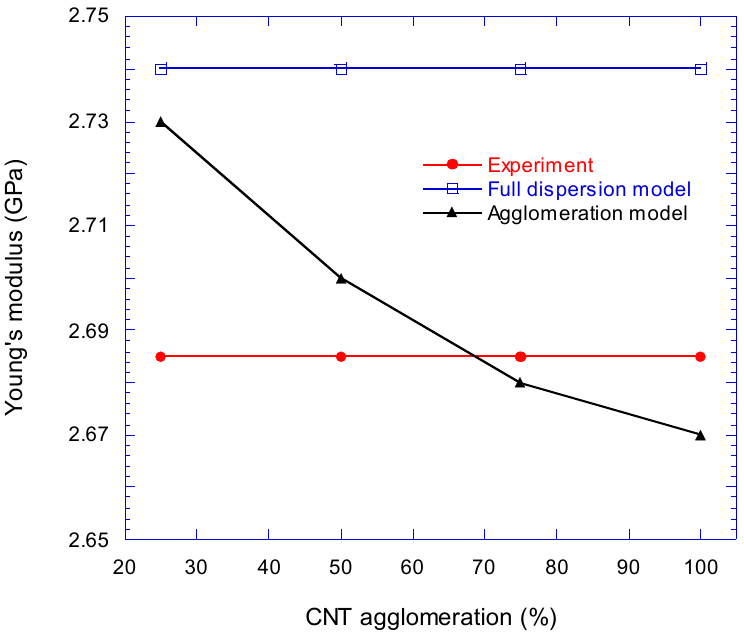
Figure 18. Effect of CNTs agglomeration on Young’s modulus of CNT/epoxy nanocomposite for four colonies model and 1 Vf.% CNT loading.